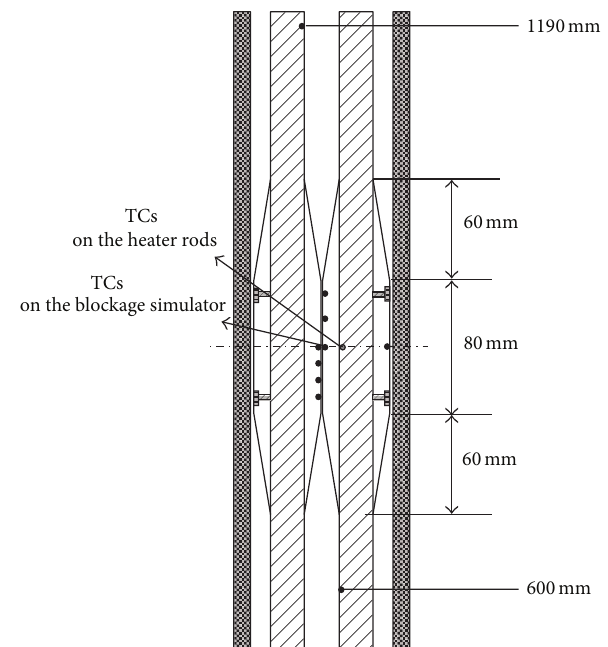
Figure 2: Schematic diagram and instrumentation of the 90% blockage simulator.